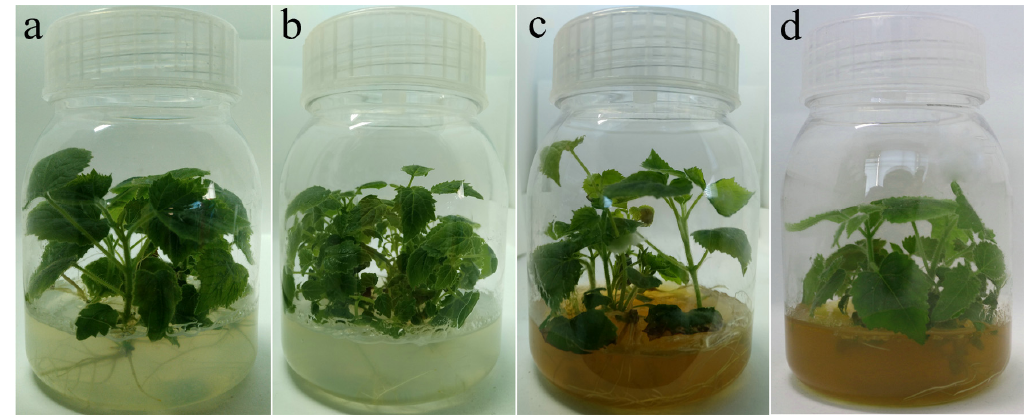
Figure 2. Rifampin treated plantlets morphology. ( a ) PT; ( b ) PTI; ( c) PT-100; ( d ) PTI-100.